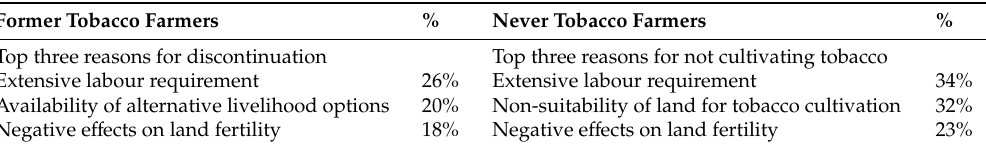
Table 15. Reasons for discontinuing tobacco production by former tobacco farmers and not producing tobacco by never tobacco farmers.